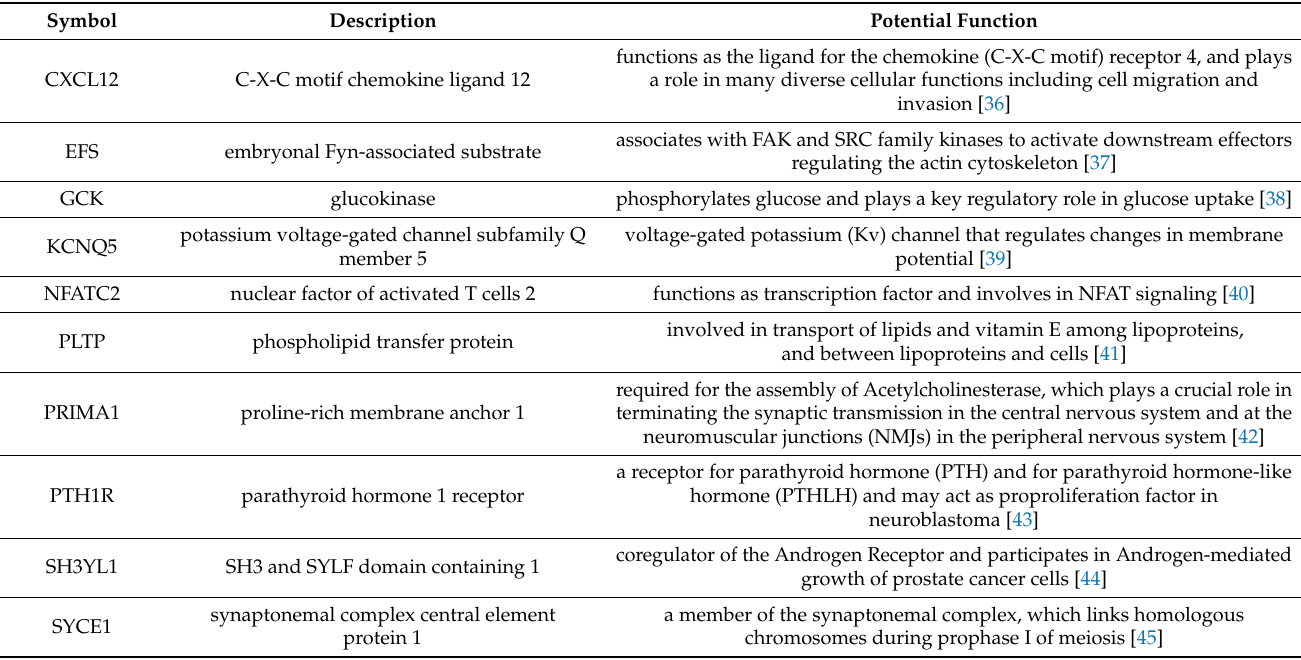
Table 1. The molecular function of 10 TSG